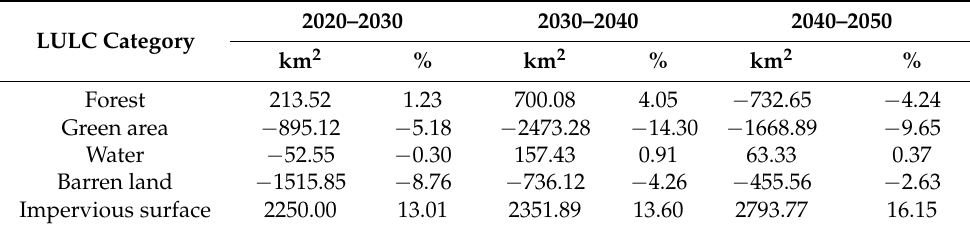
Table 17. Temporal changes 2030–2050.